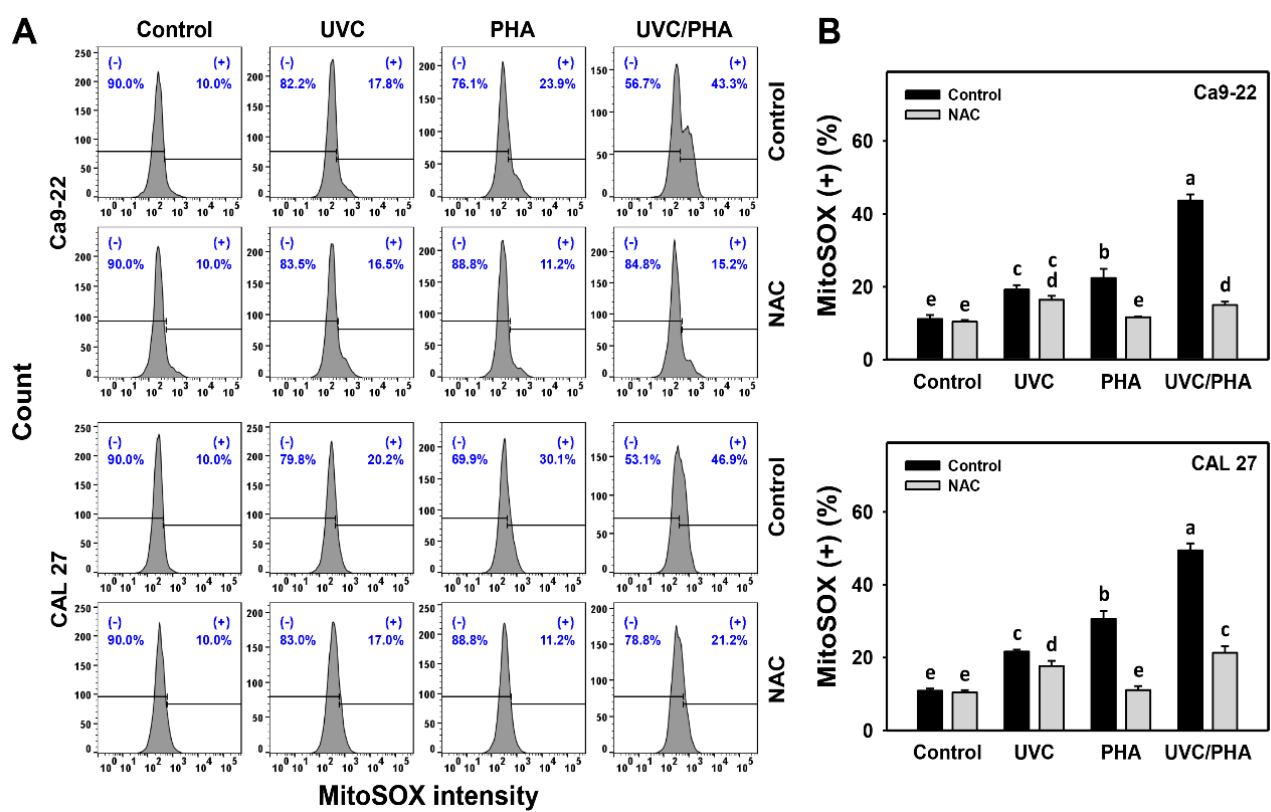
Figure 6. UVC/PHA-induced MitoSOX in oral cancer cells. In the presence or absence of NAC, oral cancer cells were grouped into four treatments, i.e., control, UVC, PHA, and UVC/PHA, for 24 h. The doses for the UVC and PHA treatments were 8 J/m 2 and 0.8 µ M, respectively. ( A , B ) Profile and data. (+) (%) indicates MitoSOX-positive (%). For comparison, treatments labeled with different letters (a to e) produced significantly different results ( p < 0.05). Data are presented as mean ± SD ( n = 3 independent experiments, with each experiment involving 5000 gated cell counts).